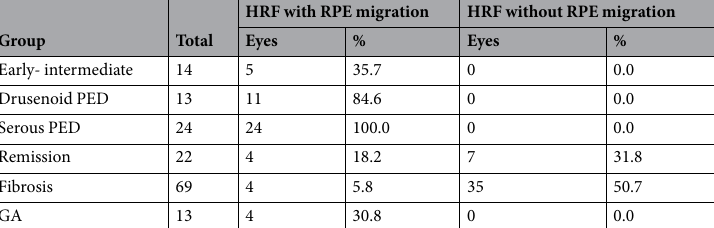
Table 1. The number of eyes in each group that had HRF with an RPE migration and without an RPE migration. HRF, hyperreflective foci; RPE, retinal pigment epithelium; PED, pigment epithelial detachment, GA, geographic atrophy.